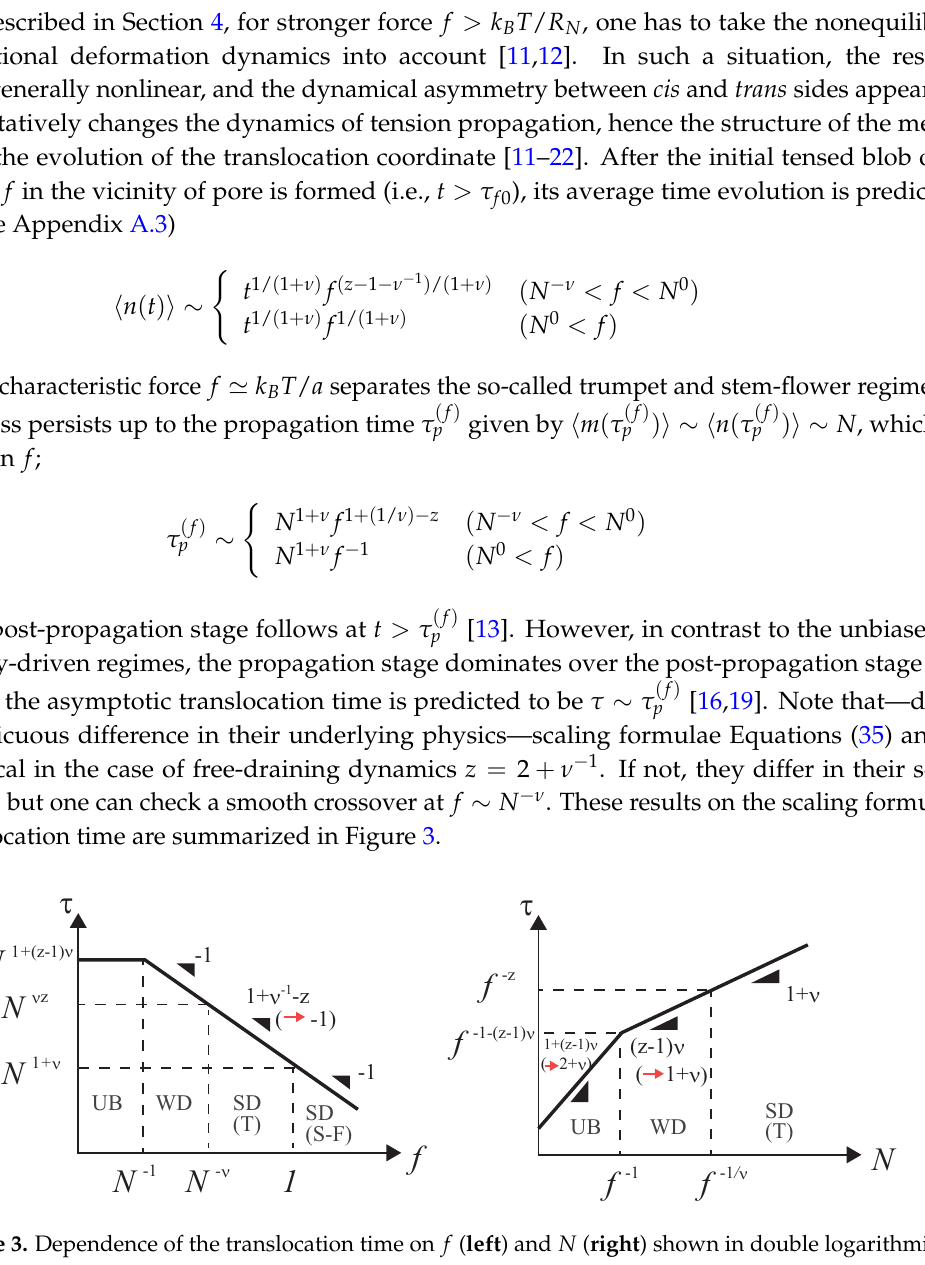
Figure 3. Dependence of the translocation time on f ( left ) and N ( right ) shown in double logarithmic scale. The locations of various regimes, unbiased (UB), weakly-driven (WD) and strongly-driven (SD) are specified; the SD regime is further divided into the trumpet (T) and the stem–flower (S-F) regimes. Note that in the right graph, depicted is the case with f < k B T / a ; otherwise, we have only S-F regime with the slope 1 + ν . Note also that in these plots, we set z = 2 + ν − 1 (free draining dynamics), in which case the plots become particularly simple. The triangles and their nearby numbers designate slopes (exponents), where the numbers after the arrows specify the values for free draining dynamics. For other choices of the dynamical exponent (i.e., z = 3 for nondraining (Zimm) dynamics), the slope in the SD (T) regime in the left graph is changed. The same applies to UB and WD regimes in the right graph. Comparing these plots with Figure 4 in Reference [16], one finds differences in weak force and short chain length